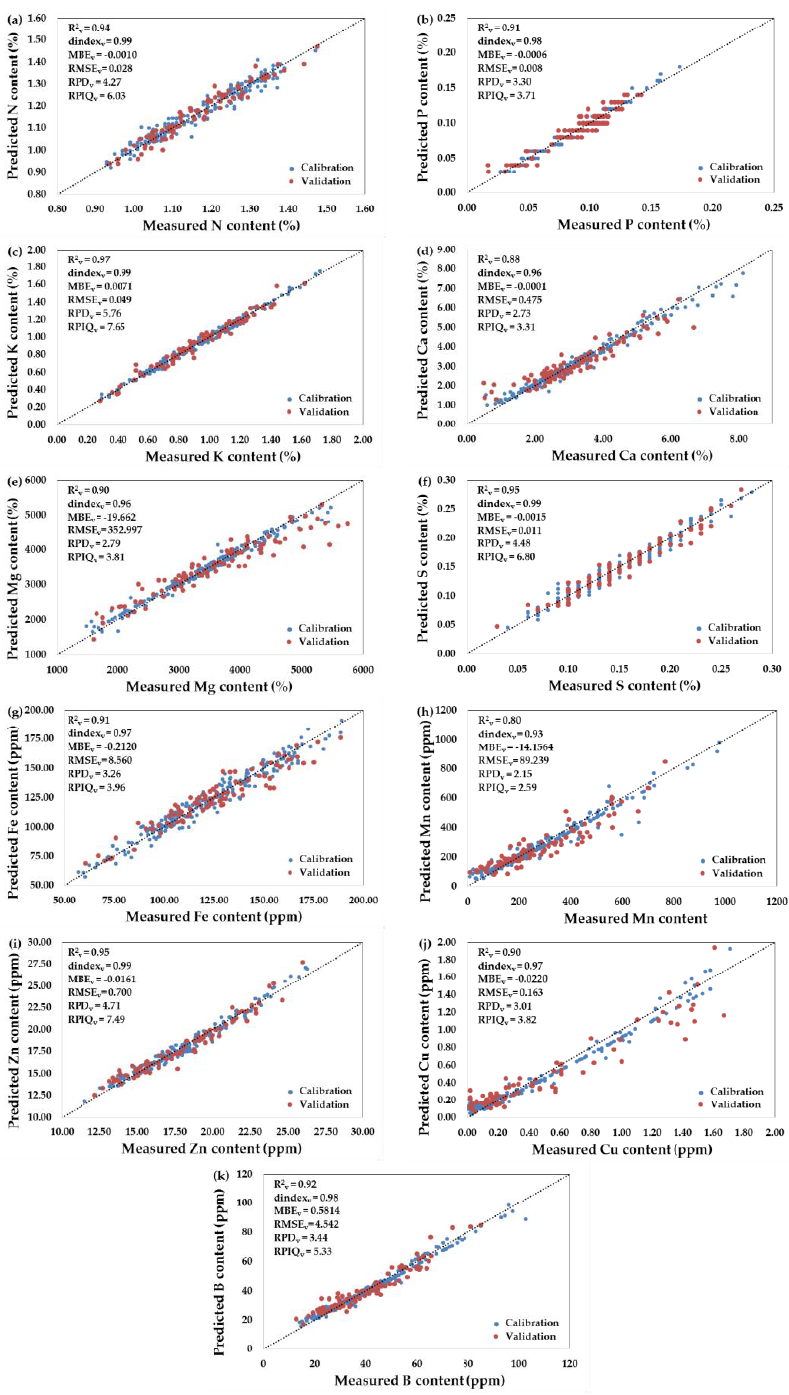
Figure 6. Performance of the best performing PLSR-combined models for predicting nutrients as ( a ) N using PLSR-Cubist, ( b ) P using PLSR-Cubist, ( c ) K using PLSR-Cubist, ( d ) Ca using PLSR-SVR, ( e ) Mg using PLSR-SVR, ( f ) S using PLSR elastic net (ELNET), ( g ) Fe using PLSR-SVR, ( h ) Mn using PLSR-SVR, ( i ) Zn using PLSR-Cubist, ( j ) Cu using PLSR-SVR, and ( k ) B using